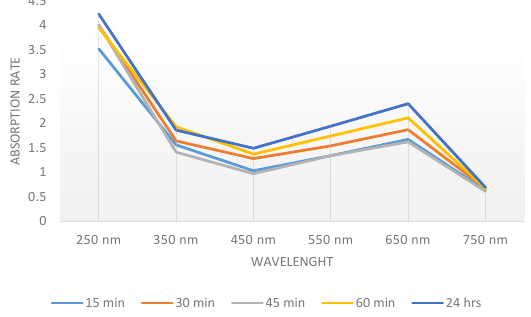
Fig. 1. Peak absorbance of copper acetate Nano particles at 650nm Fig 1. Peak absorbance of copper acetate Nano particles at 650nm